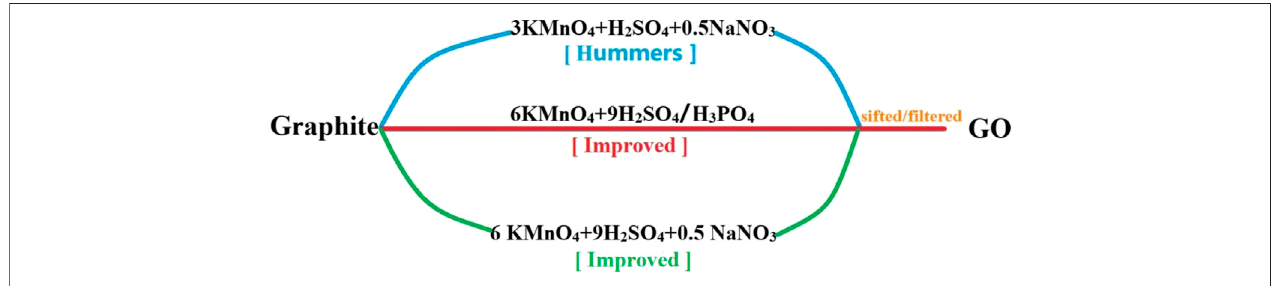
FIGURE 4 | Different conversion pathways from graphene to GO.